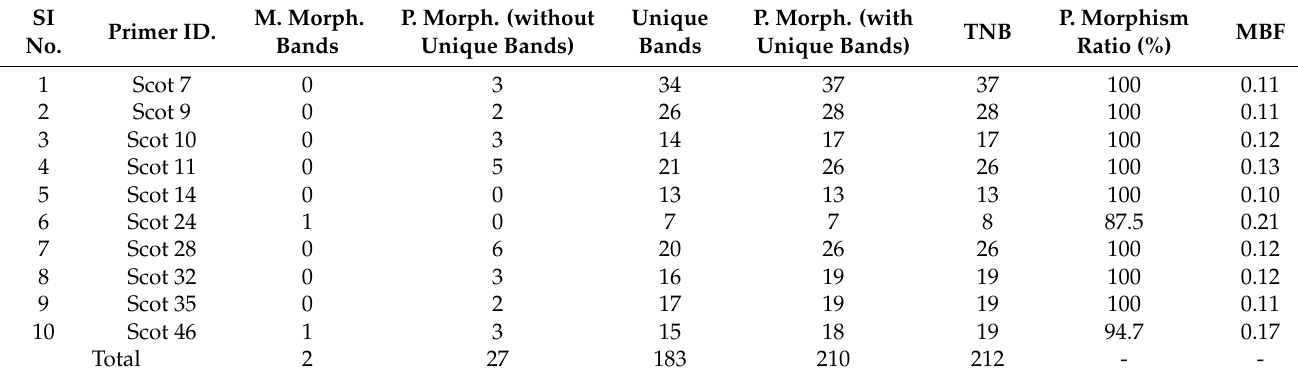
Table 5. Data of SCoT primers and the extent of polymorphism. It included Monomorphic bands (M. morph.), Polymorphic (without unique bands) (P. morph. Without unique bands), Polymorphic (with unique bands) (P. morph. With unique bands), Total number of bands (TNB), Polymorphism ratio (%) (P. morphism ratio (%)), Mean of band frequency (MBF). SI Primer No.